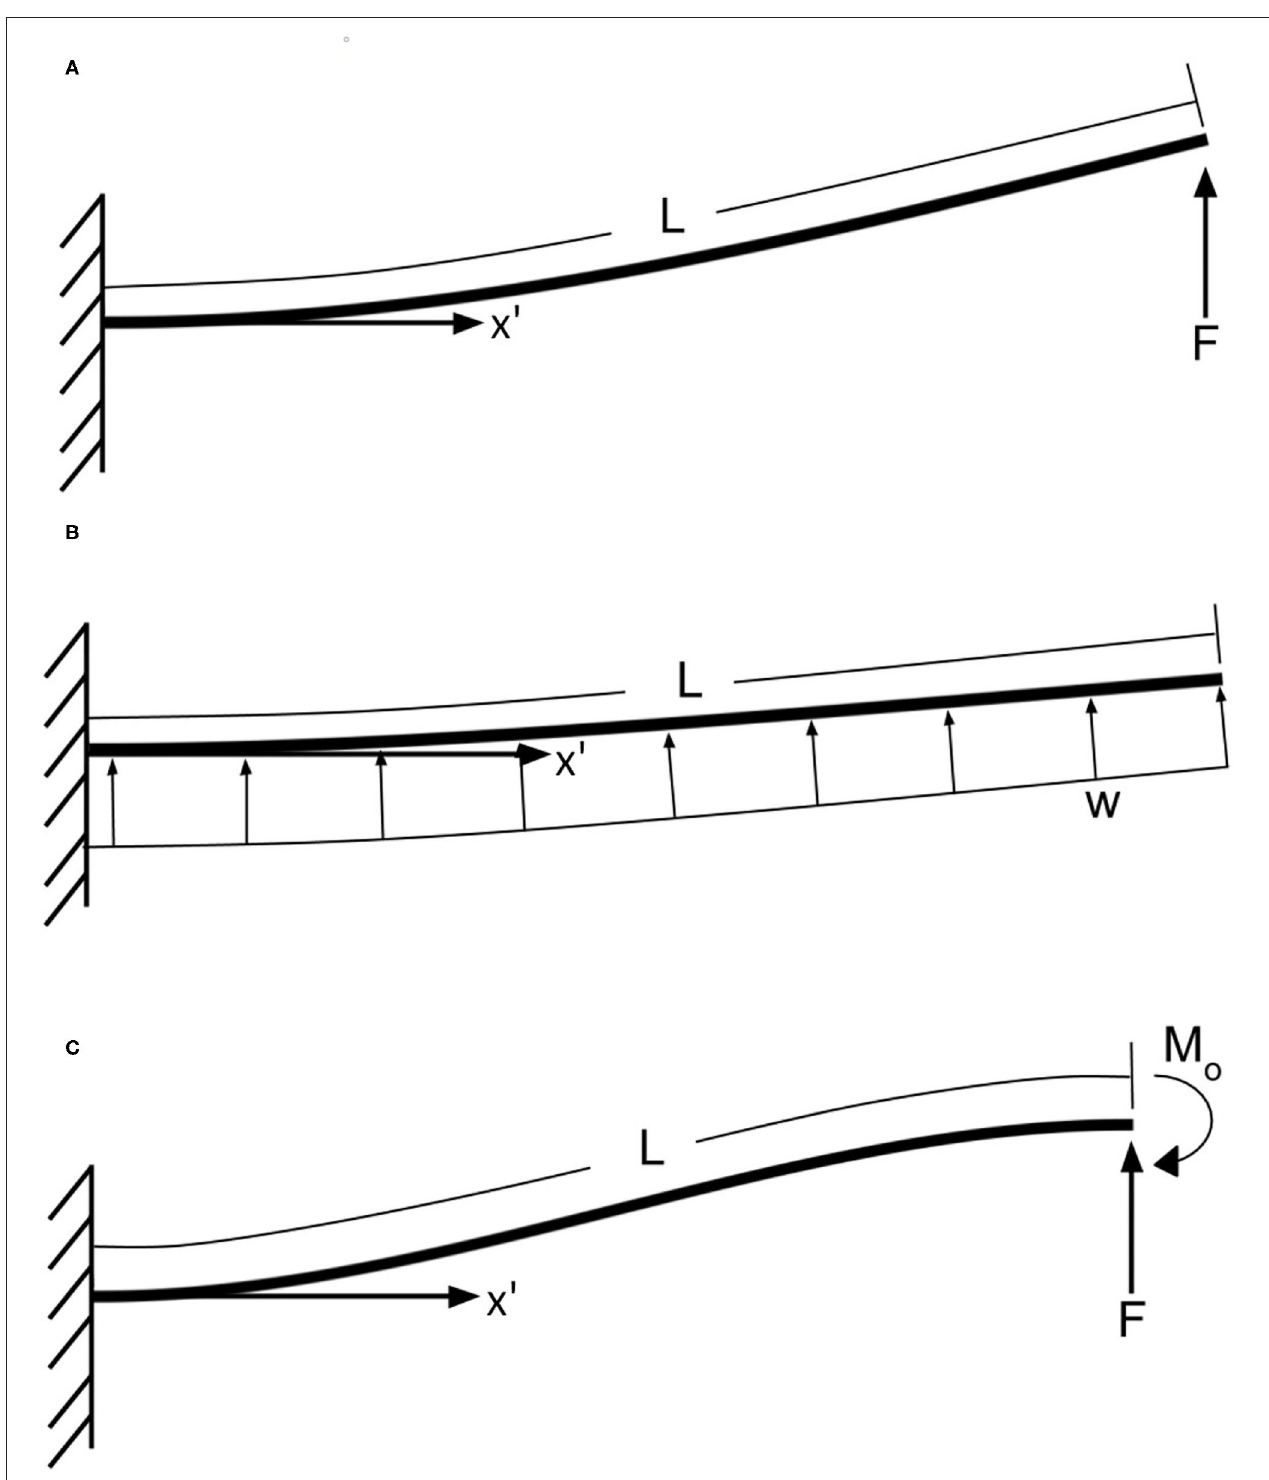
FIGURE 5 | (A) End force load, (B) uniformly distributed load, (C) beam with one end fixed and the other end guided. L is the arc length of the full joint, F is an end load amount, w is a distributed load, and M 0 is a moment.